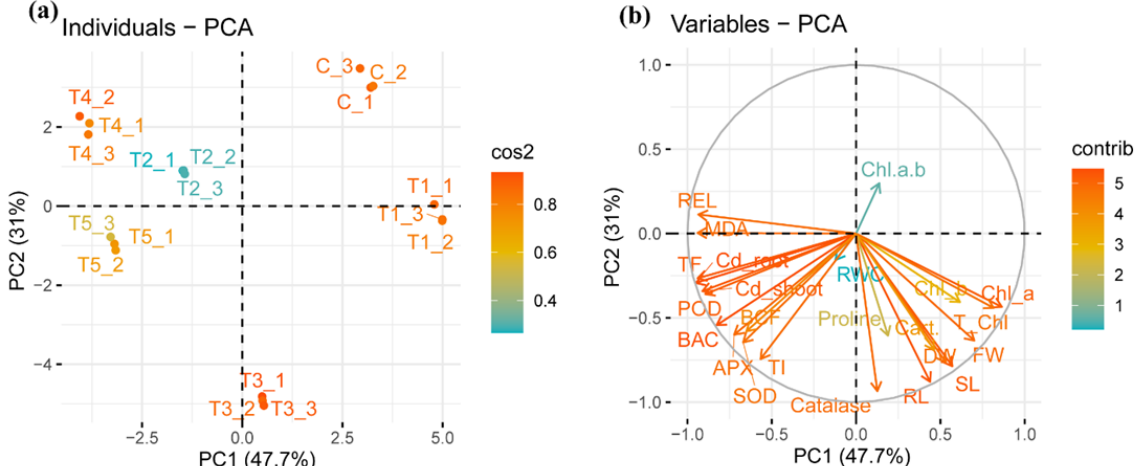
Figure 5. Score ( a ) and loading plot ( b ) of principal component analysis (PCA) on different studied attributes of A. rosea seedlings/plants supplemented with citric acid (CA) while grown under Cd stress. Where PC stands for pearson’s correlation; REL for relative electrolyte leakage; TF for translocation factor; POD for peroxidase; APX for ascorbate peroxidase; BAC for bioaccumulation concentration; APX for ascorbate peroxidase; SOD for superoxide dismutase; RL for root length; SL for shoot length and RWC for relative water content.